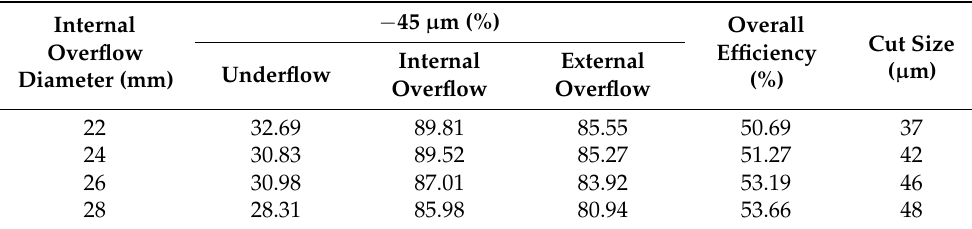
Table 4. Effect of changing the diameter of the inner vortex finder on the separation performance of a hydrocyclone.